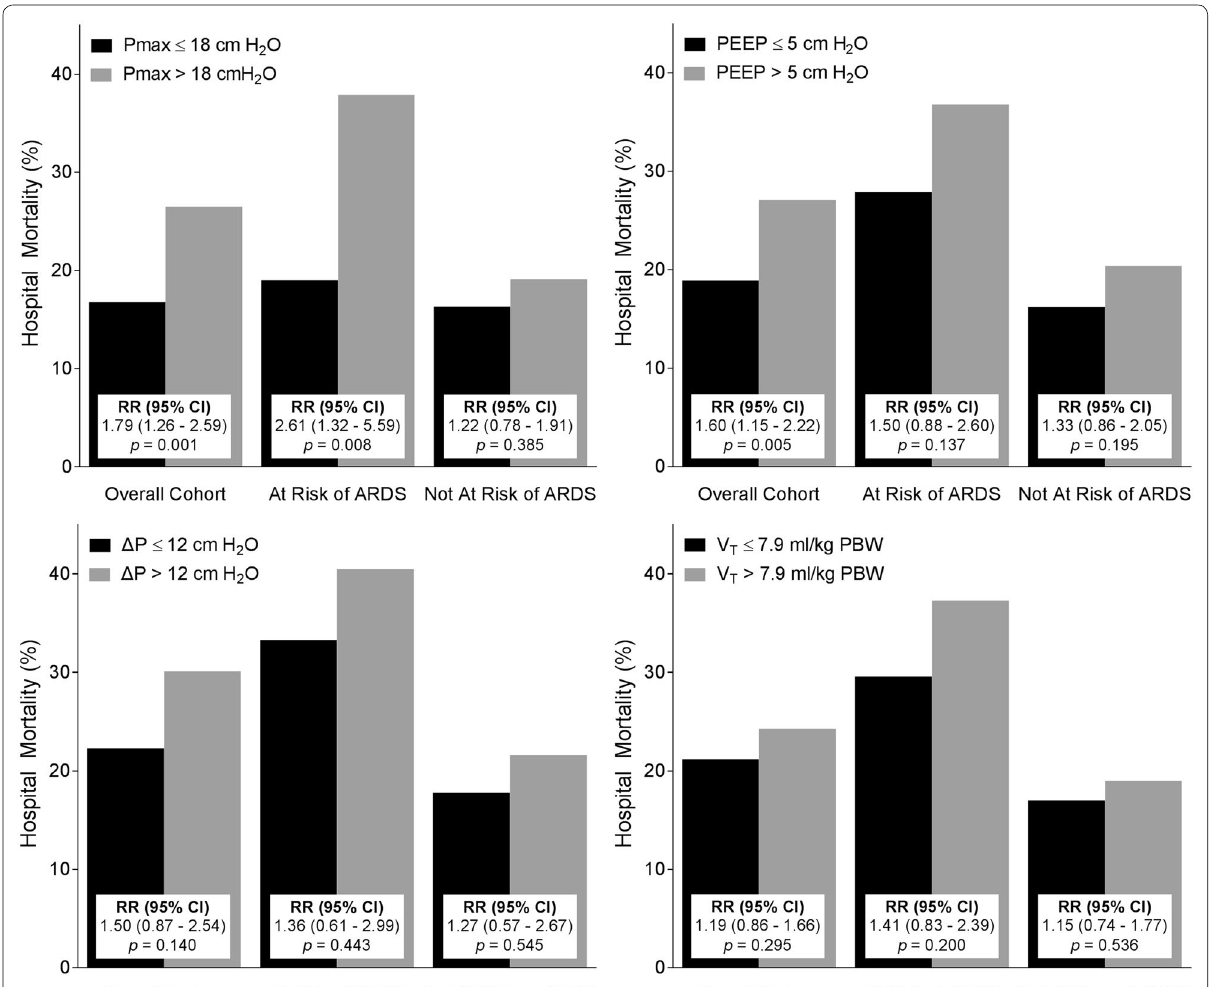
Fig. 2 Unadjusted relative risks of hospital mortality in the overall cohort and in patients at risk and not at risk of ARDS and according to the median of the: a P max ; b PEEP; c ∆ P ; and d tidal volume. Abbreviations: P max : maximum airway pressure; PEEP: positive end‑expiratory pressure; V T : tidal volume; ∆ P : driving pressure; RR: relative risk; CI: confidence